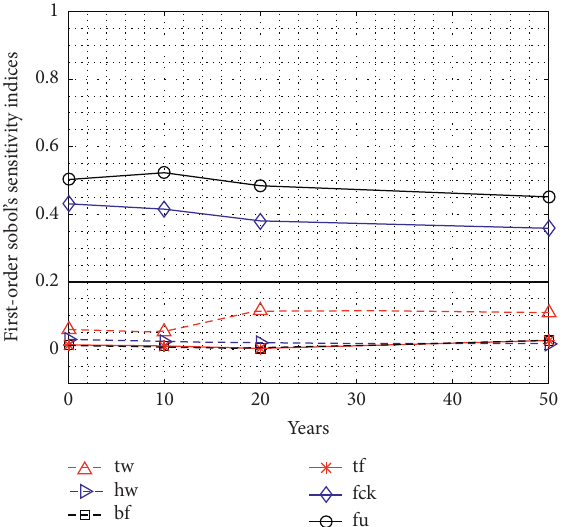
Figure 17: First-order Sobol’s sensitivity indices of the SCC beams considering 0-year, 10-year, 20-year, and 50-year corrosion levels.